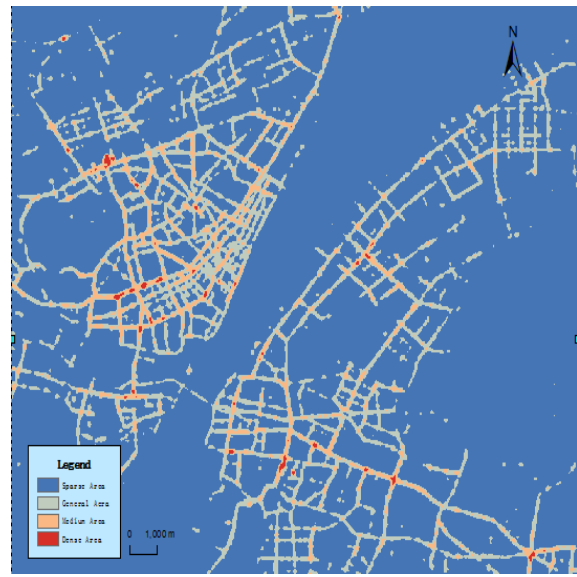
Figure 1. Hotspot regions with various grades